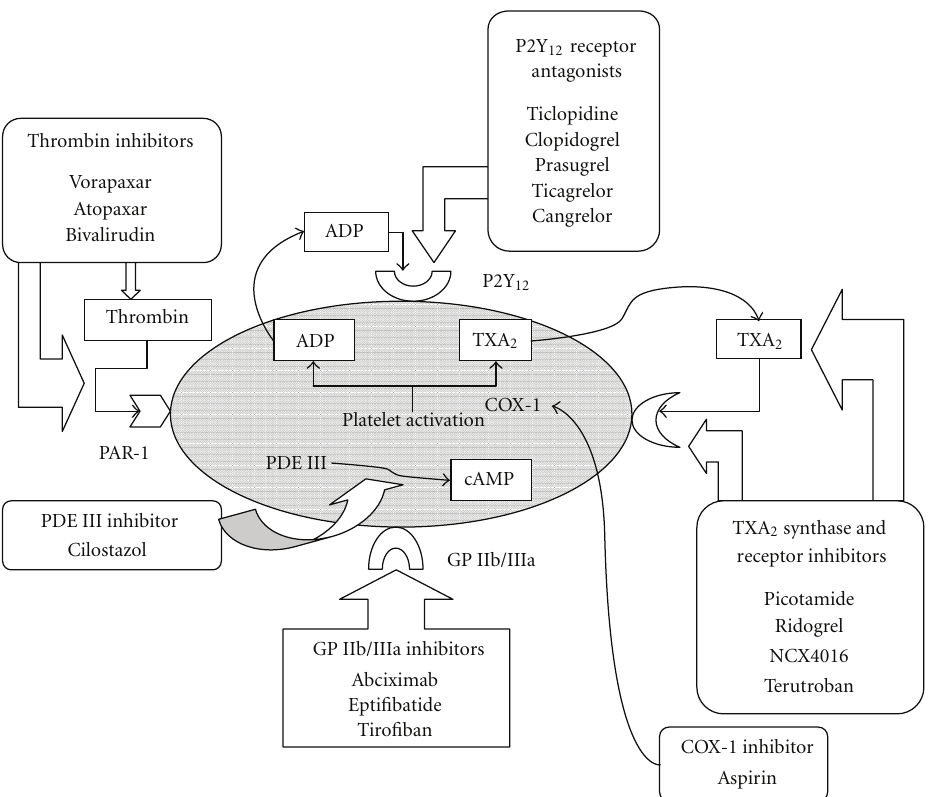
Figure 2: Schematic representation of mechanisms of action of antiplatelet agents. PAR-l: protease activated thrombin receptor-1. Adapted from